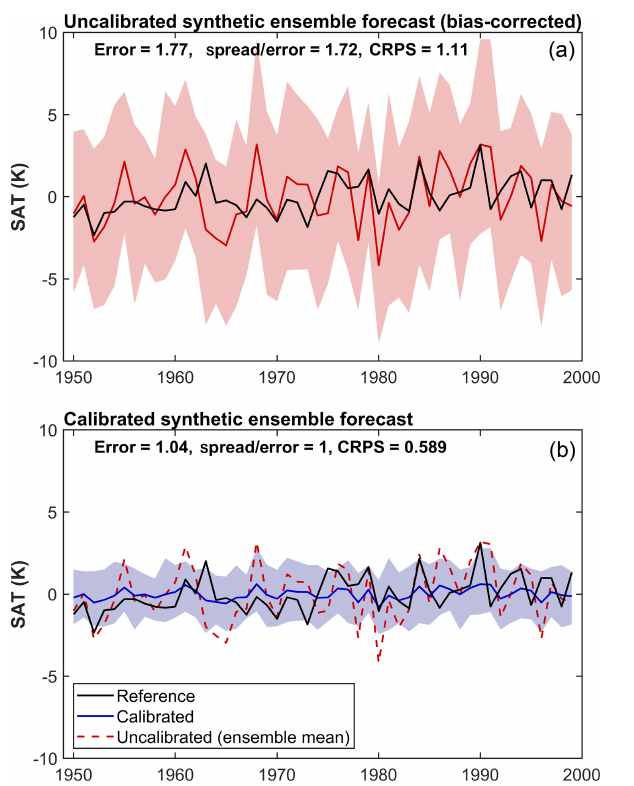
Figure 2. (a) Synthetic data for an example (bias-corrected) ensem- ble temperature evolution are shown for the ensemble mean in red and 90% ensemble range (shaded), along with the synthetic (ob- servational) reference index in black. (b) The synthetic ensemble calibrated using the variance inflation method to match the refer- ence dataset is shown in blue, with the raw ensemble mean shown in dashed red. The RMSE, spread / error ratio and CRPS calculated for the raw ensemble and the calibrated ensemble are all